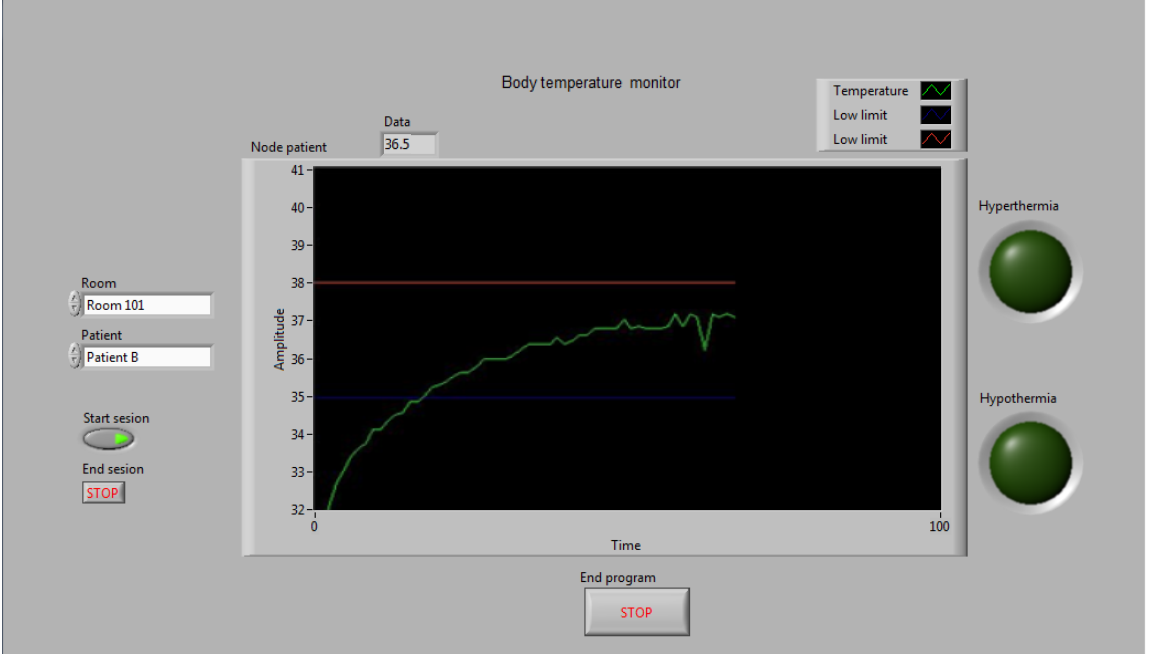
Body temperature